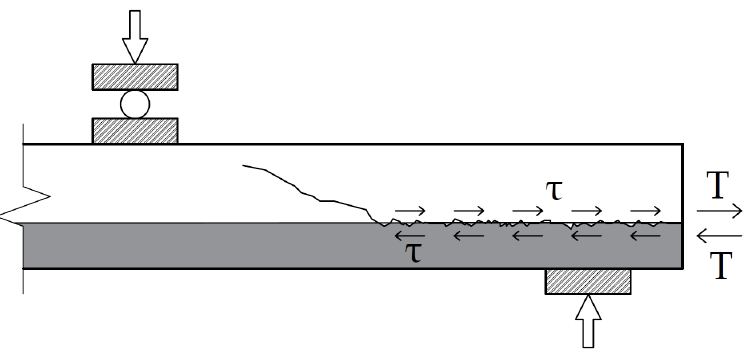
Figure 2. The failure mode of the layered structure in the support zone.